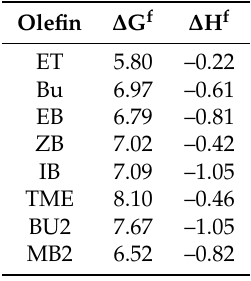
Table 1. Calculated free energies and free enthalpies of the formation of MA-olefin